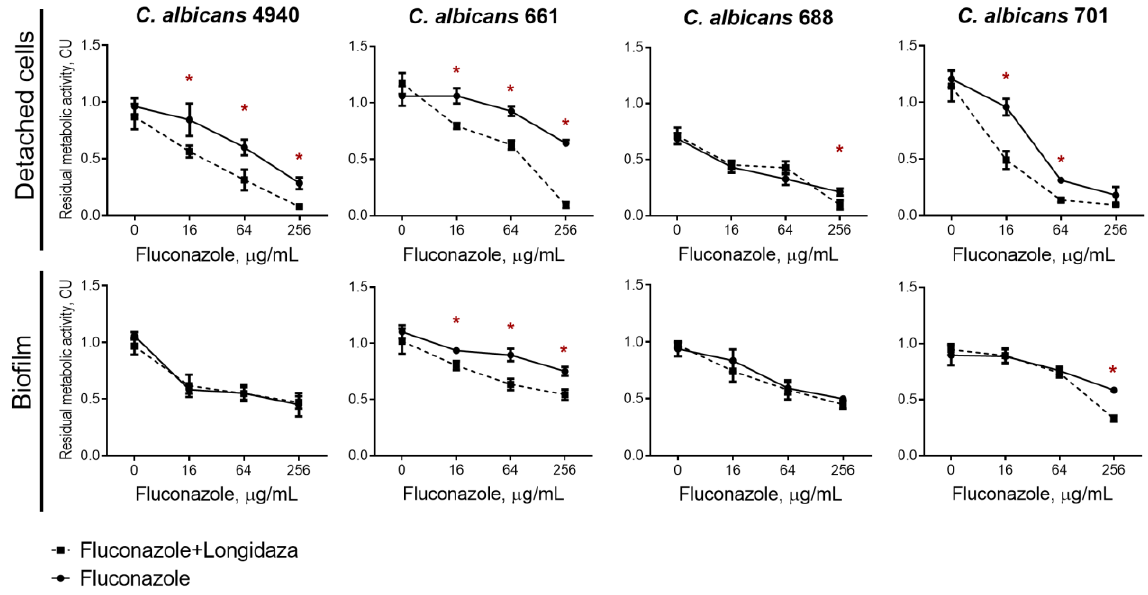
Figure 6. The effect of Longidaza ® on the susceptibility of detached and biofilm-embedded C. albicans cells to fluconazole. Longidaza ® was added to 48-h-old biofilms to a final concentration of 3000 IU/mL. Fluconazole was added up to final concentrations of 16 − 256 µg/mL. After 24 h incubation, the biofilms were washed twice with sterile 0.9% NaCl. The viability of cells was analyzed with an MTT-assay. The asterisks (*) denote a statistically significant difference of the residual respiratory activity in the untreated wells (solely antimicrobials) and wells with the combined treatment ( p < 0.05).